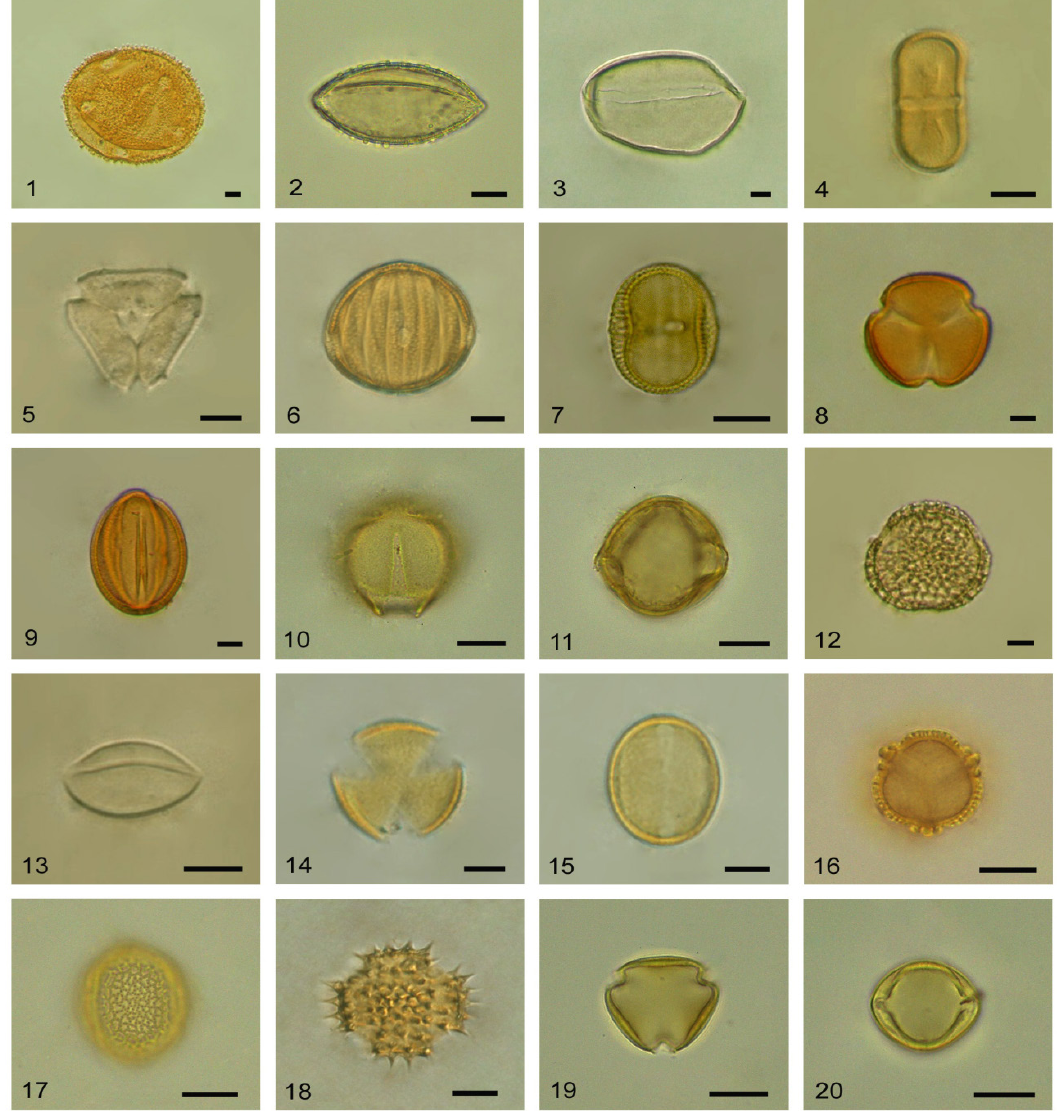
Fig 2 . Micrographs of some pollen types obtained from body surface of T . iridipennis . 1. Alangium salviifolium . 2. Borassus flabellifer . 3. Cocos nucifera . 4. Coriandrum sativum . 5. Eucalyptus tereticornis . 6. Hygrophila auriculata . 7. Justicia simplex . 8–9. Leucaena leucocephala . 10–11. Moringa oleifera . 12. Peltophorum pterocarpum . 13. Phoenix sylvestris . 14–15. Tectona grandis . 16–17. Tinospora cordifolia . 18. Tridax procumbens . 19–20. Ziziphus mauritiana . Scale bars - 10